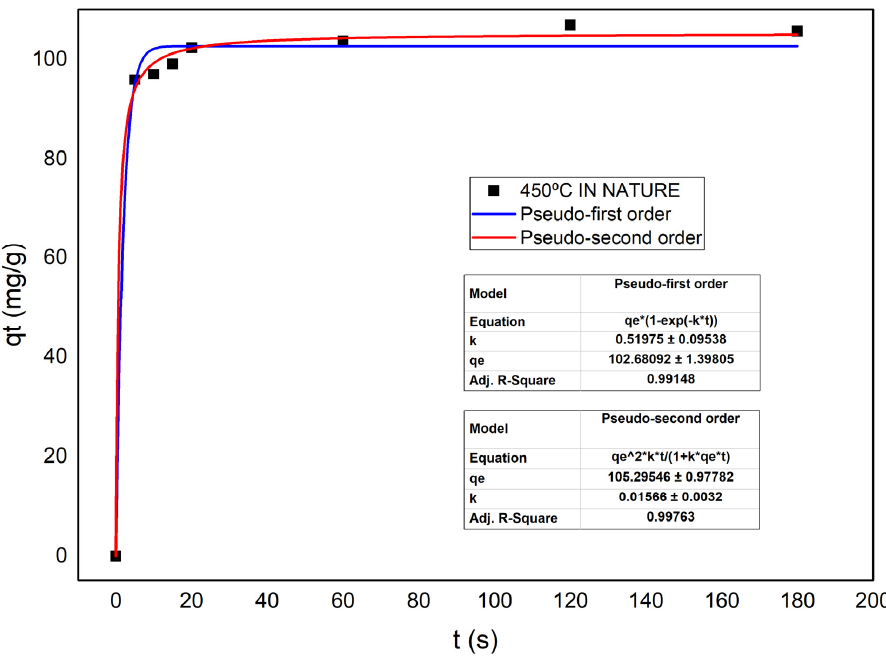
Figure 11. Pseudo-first-order and pseudo-second-order models for adsorption experiment of in nature biochar obtained at 450 °C.